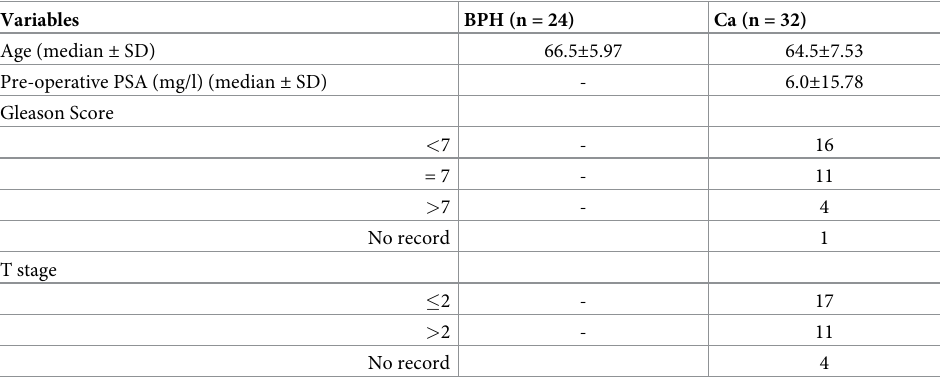
Table 2. Patient characteristics of cohort of specimens at SFVAHCS for miRNA PCR analyses.